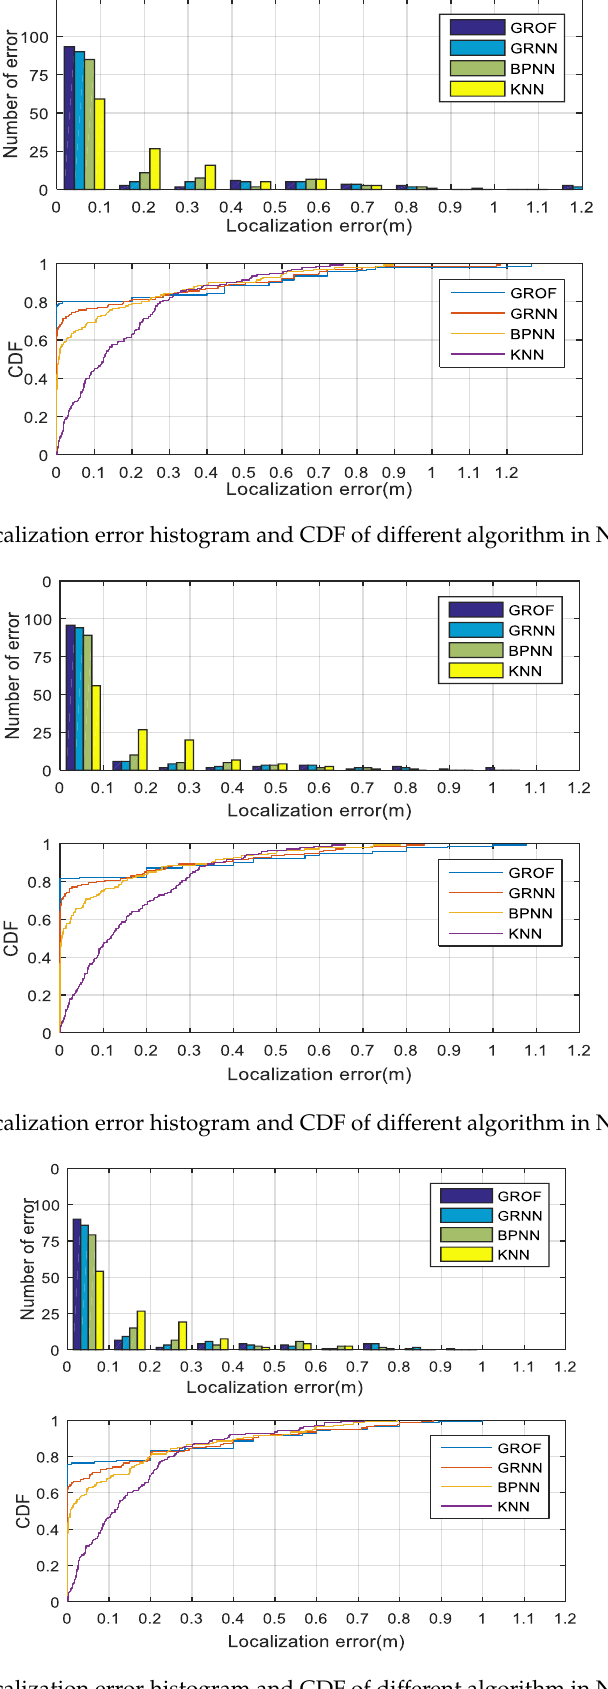
Figure 19. Localization error histogram and CDF of different algorithm in NLOS Case 3.